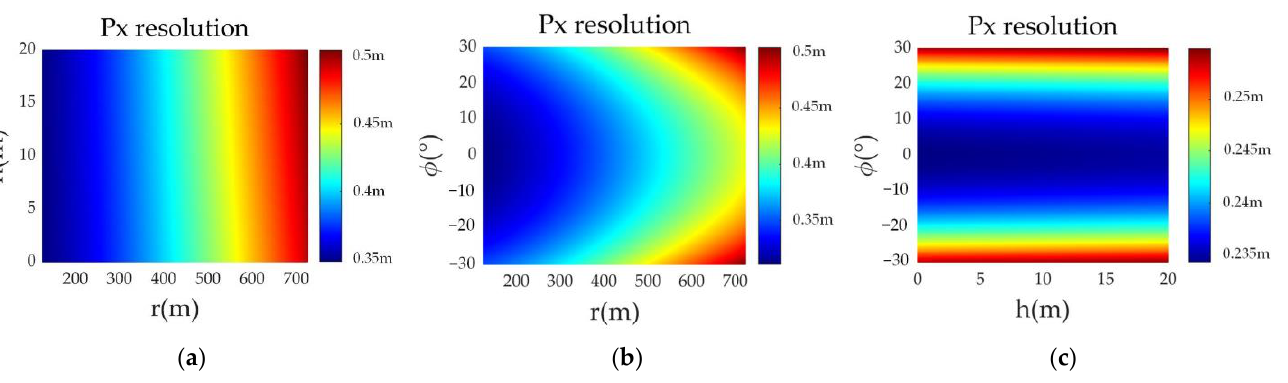
Figure 6. Along-track resolution of targets at different positions. ( a ) The target azimuth angle is 30°; ( b ) the target height is 10 m; ( c ) the target distance is 200 m.